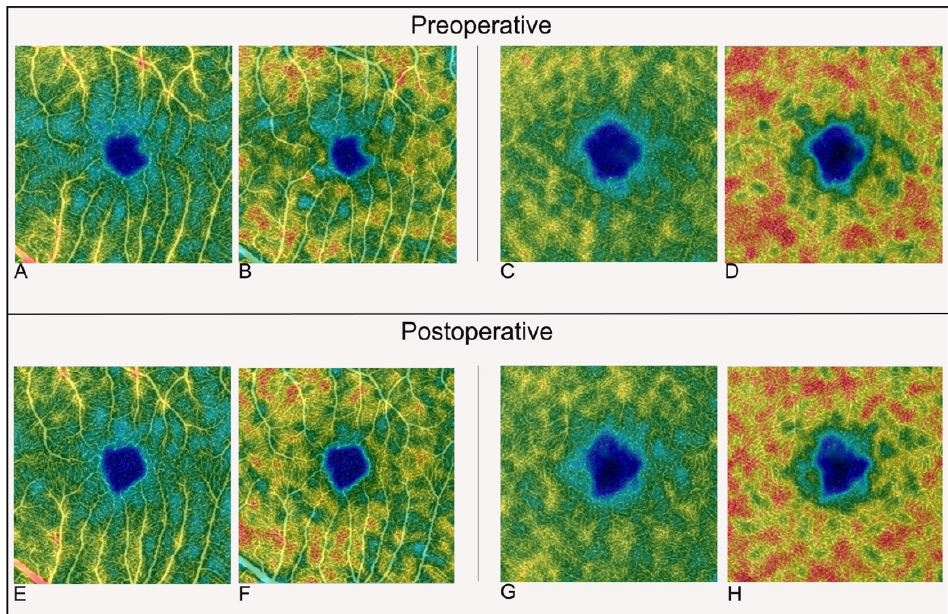
Figure 2. Optical coherence tomography angiography 3 × 3 density map images in macula ON rhegmatogenous retinal detachment eyes. Preoperative vessel density and vessel length density of superficial capillary plexus ( A , B ); vessel density and vessel length density of deep capillary plexus at preoperative time ( C , D ). Postoperative vessel density and vessel length density of superficial capillary plexus ( E , F ); Postoperative vessel density and vessel length density of deep capillary plexus ( G , H ).